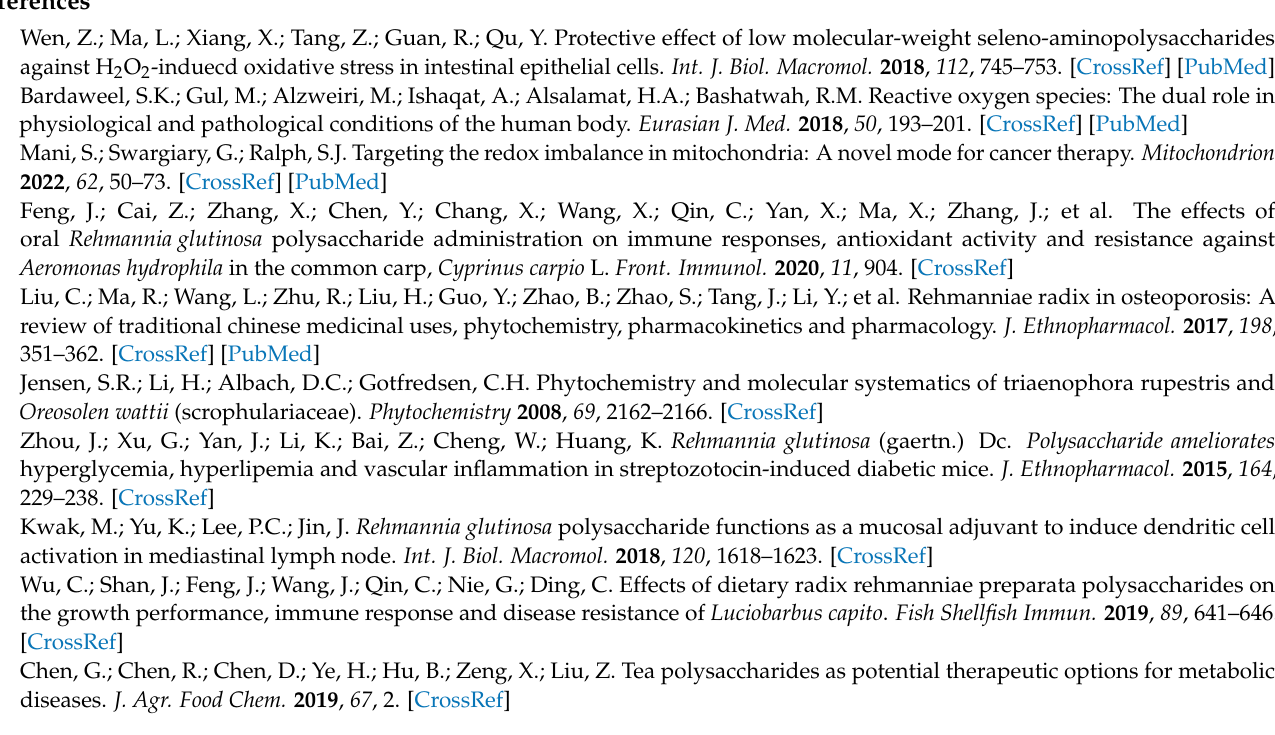
( B ); Table S1: Primer sequences used in quantitative real-time polymerase chain reaction; Table S2: The program for real-time fluorescent quantitative PCR